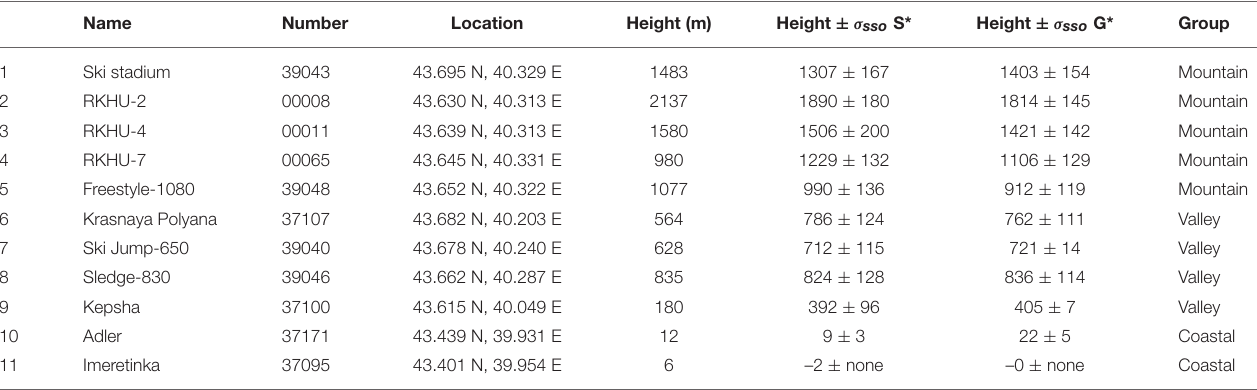
TABLE 3 | Summary of the observation sites used in the